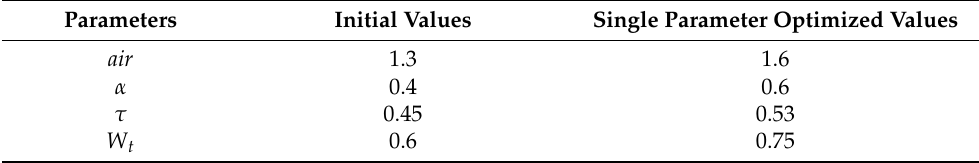
Table 3. The result of single parameter optimizations.